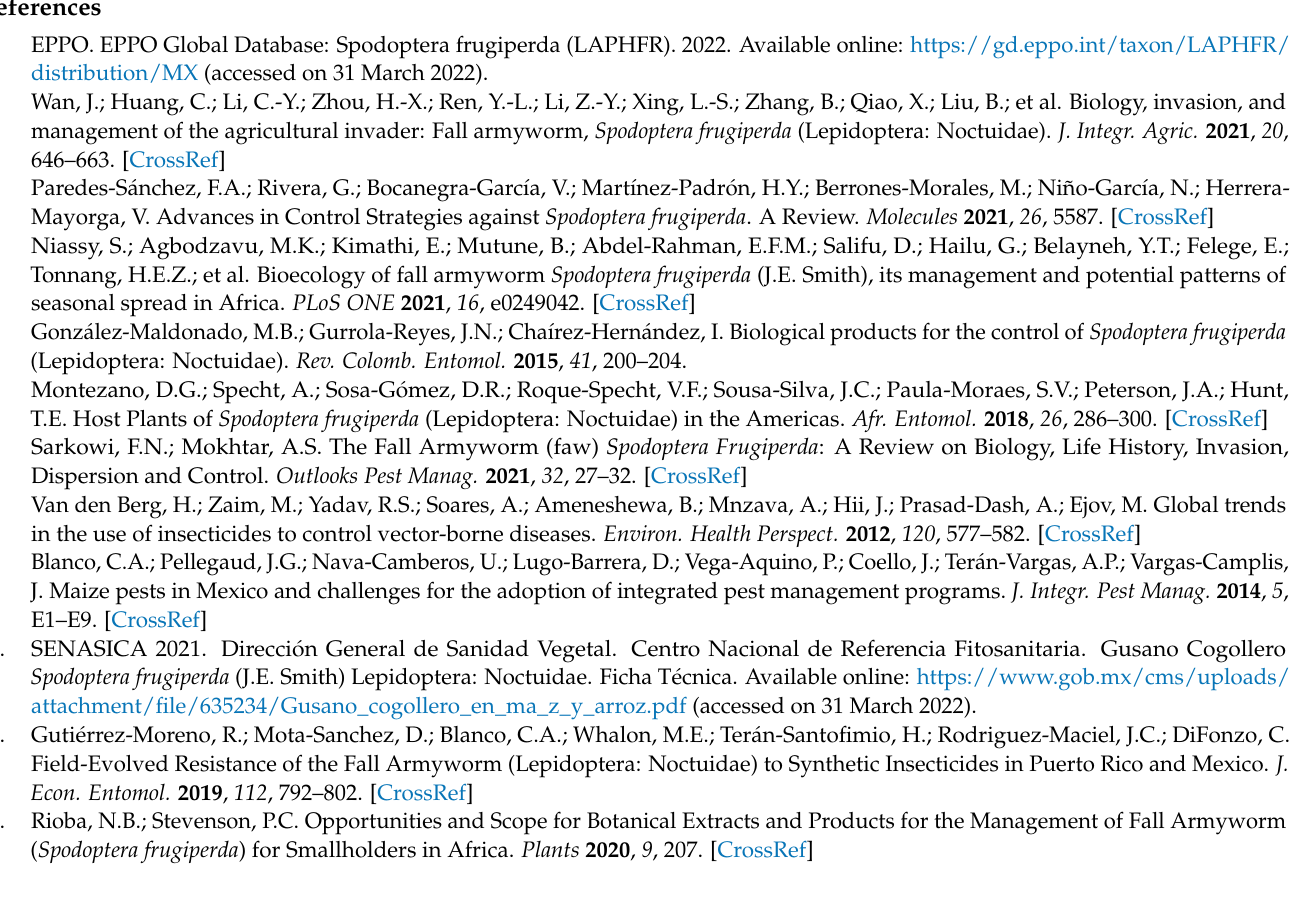
and Table S2: Compounds identified in the chromatographic analysis of Neem oil used as a positive control in the present